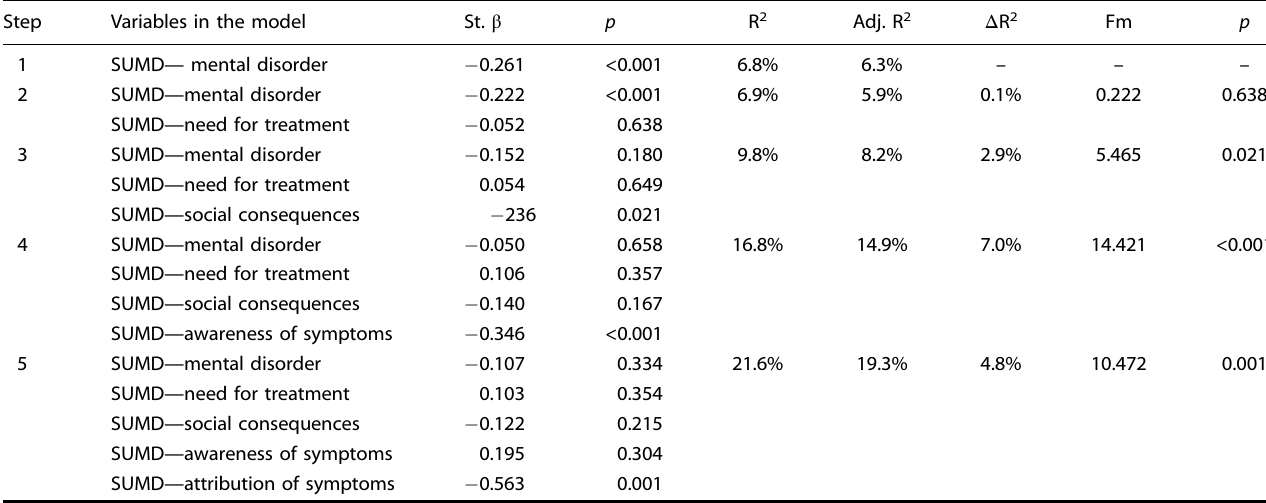
Table 3. Relative contribution of insight aspects to intrinsic motivation: fi rst hierarchical regression analysis ( n = 176).